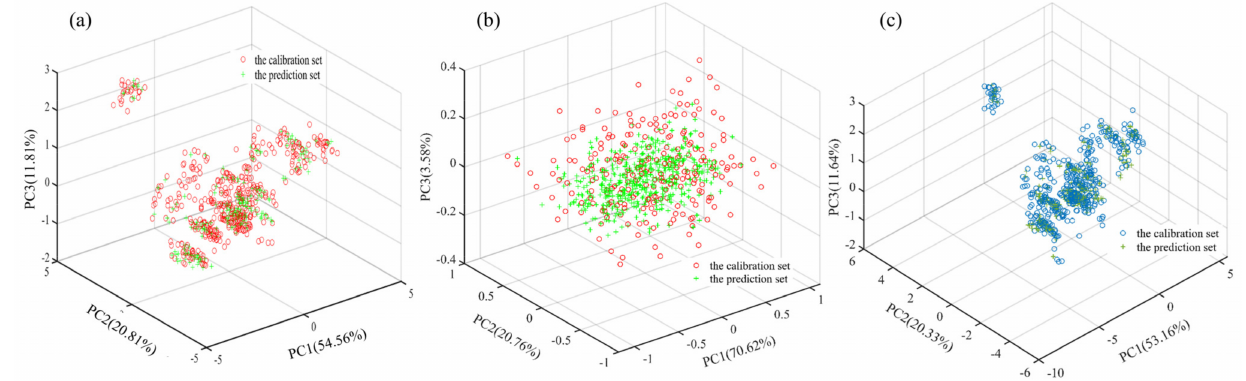
Figure 3. Distributions of Dianhong tea samples from the calibration set and the prediction set in the three − dimensional principal components space. ( a ) ET taste features; ( b ) spectral features; ( c ) data